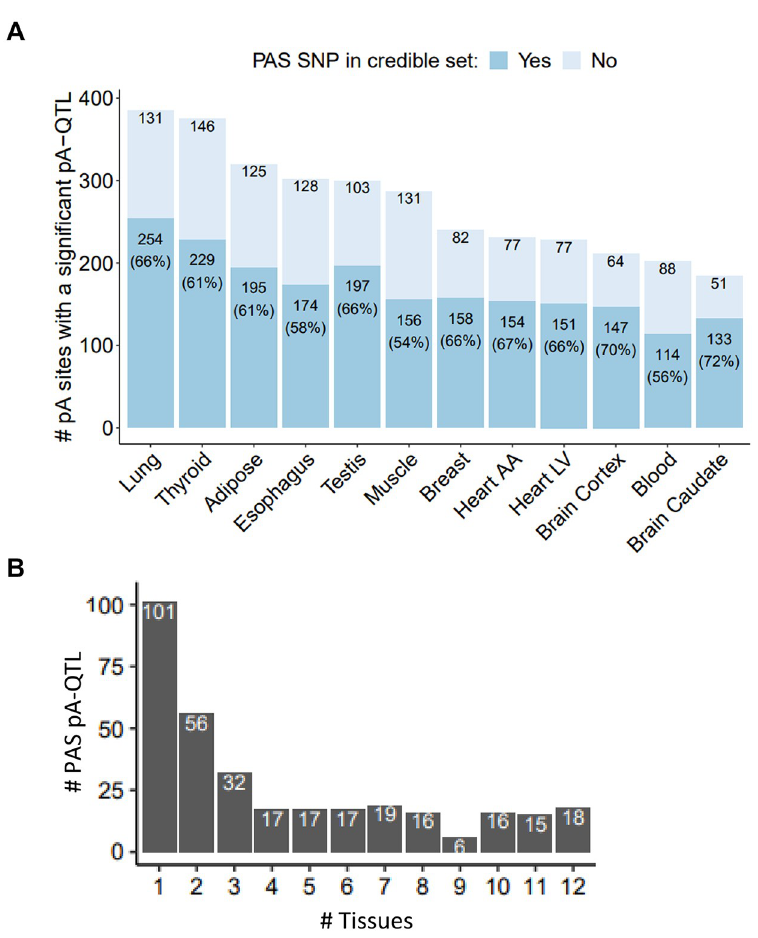
Fig 3. PAS SNPs indicated by CAVIAR as putative causal pA-QTLs. A. Bars showing the number of pA sites significantly associated with pA-QTLs per tissue, and the proportion of cases in which the corresponding PAS SNP is included in CAVIAR’s credible set. B. Distribution of the number of different tissues in which each PAS SNP was indicated as pA-QTL variant. 49 PAS SNPs were indicated as causal pA-QTLs in at least 10 tissues.